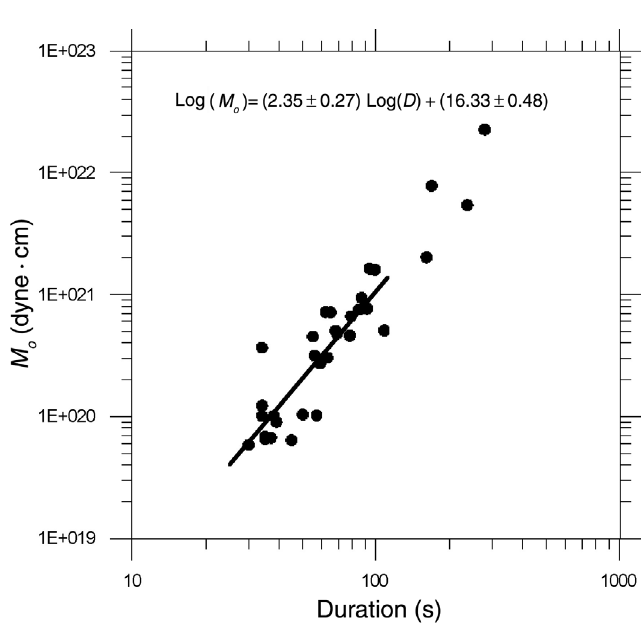
Fig. 3. Seismic moment ( M o )-coda duration relation of Dahshour aftershocks.